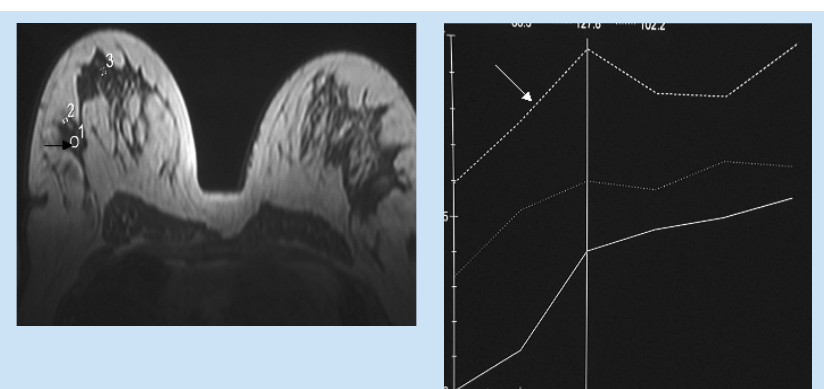
Figs 3c,d.T1 and T1 fat-saturated contrast-enhanced transverse images of the right breast demonstrate the focal mass as a low-density spiculated lesion on T1 (arrow 3c) which enhances markedly after con- trast injection (arrow 3d) which is suspicious for a new cancer.